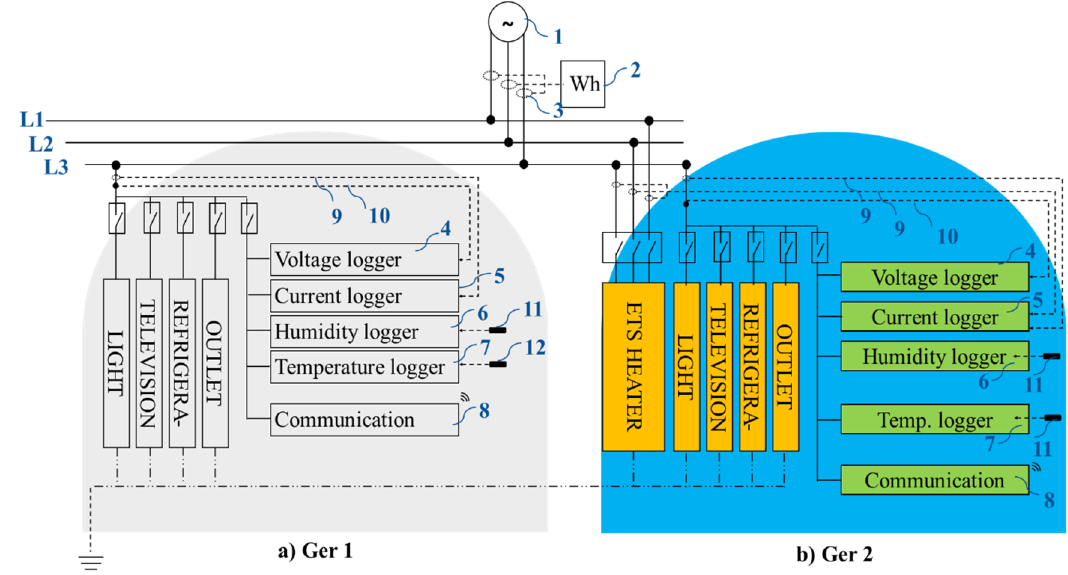
Figure 2. Diagram of the experimental setup and electrical wiring of ( a ) Ger 1 and ( b ) Ger 2. Grey color presents Ger 1. Its electric appliances were supplied from the main grid, and its measurements are shown, while the light blue color indicates Ger 2.